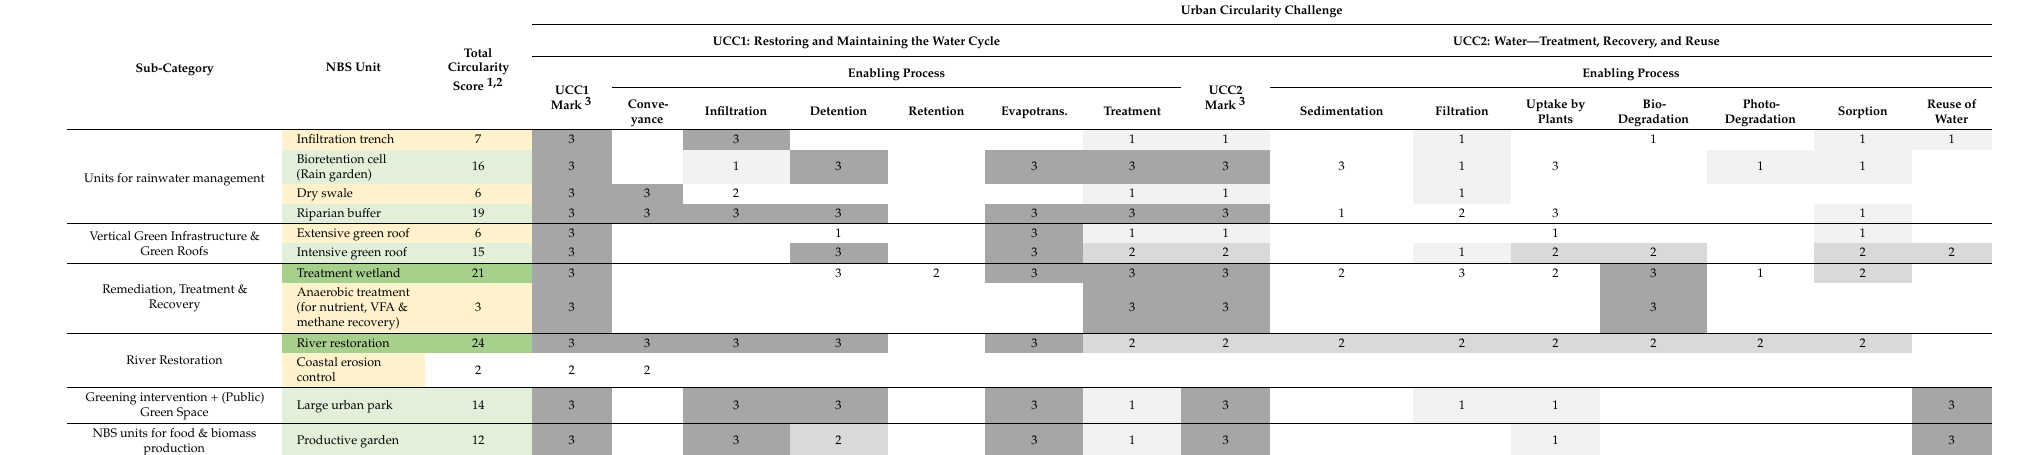
Table 4. Case-based (Table A1) qualitative assessment of the 12 selected NBS